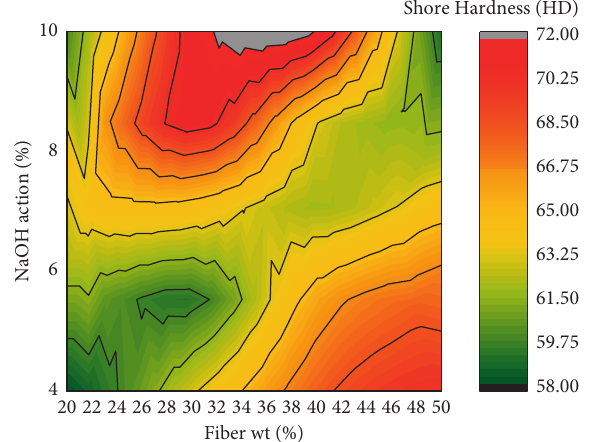
Figure 24: Shore D hardness: contour plot of temperature and compression pressure.